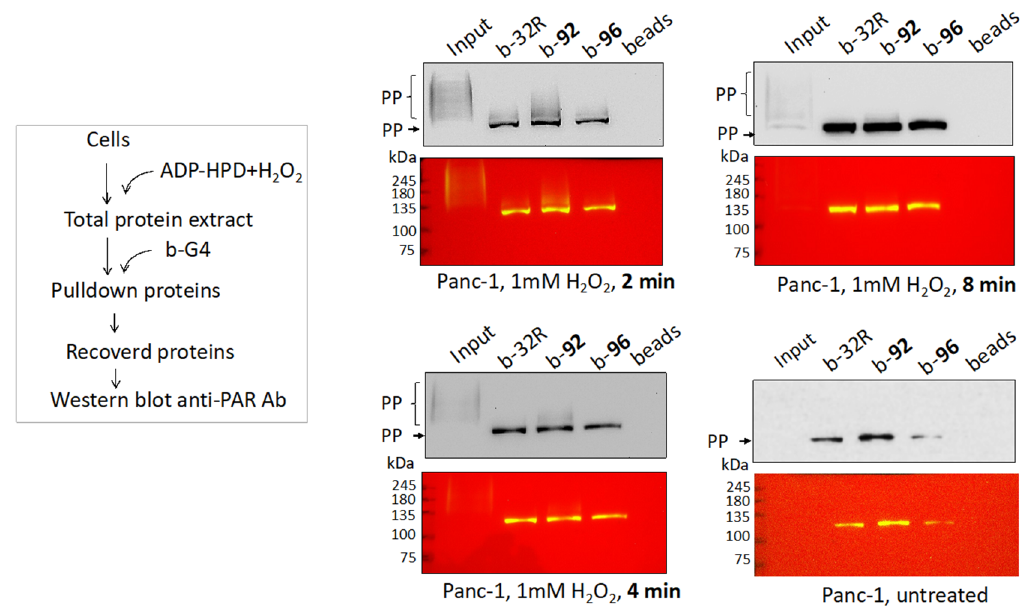
Figure 6. Western blots showing that b-32R and its oxidized variants b- 92 and b- 96 , pulled down PARylated proteins, from Panc-1 cells treated with H 2 O 2 . Pulled-down PARylated proteins migrate in the gel with a strong band of approximately 120–125 kDa. In contrast, the input, composed by proteins that have not been pulled down with a G4 bait, shows PARylated proteins that have molecular weights > 125 kDa. Membrane replicas showing the protein markers are also reported, PP = PARylated proteins.